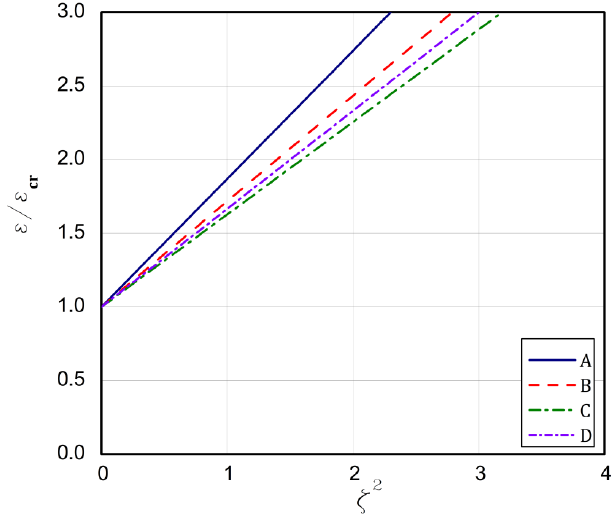
Figure 5. The post-buckling paths ε / ε cr in a function of ζ 2 for type 3 of loads of the perfect plates.